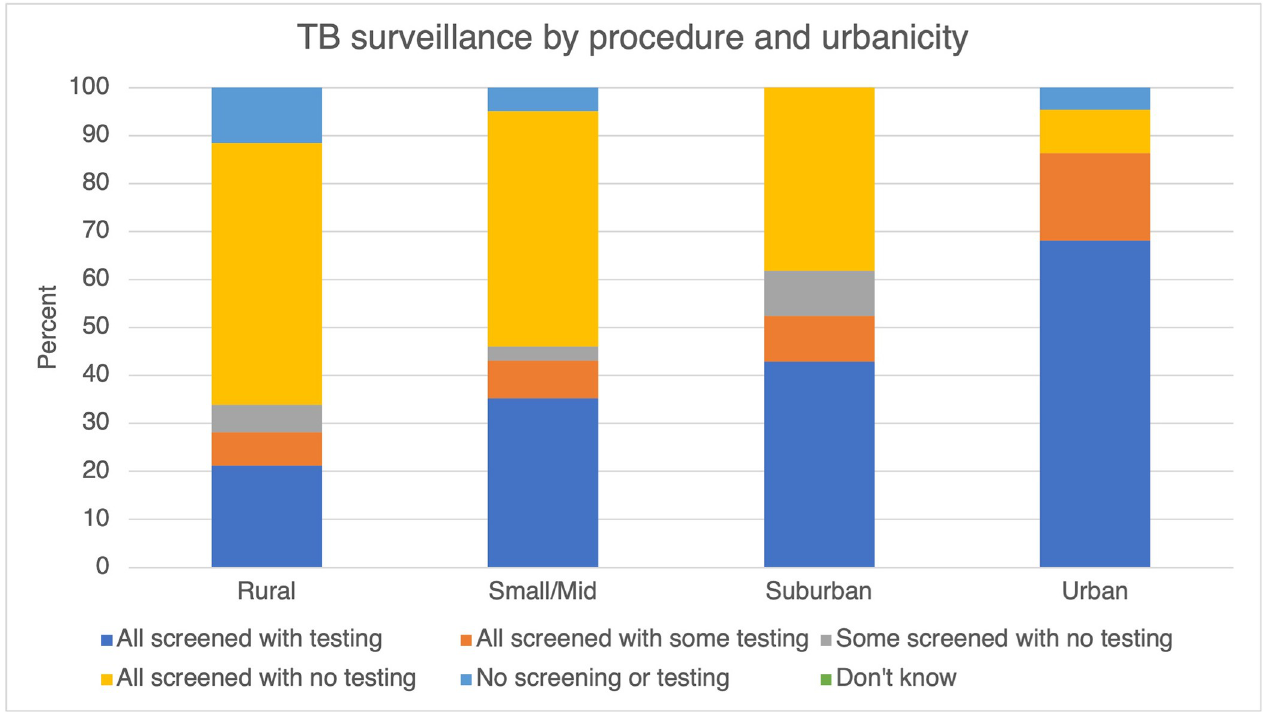
Fig 3. TB surveillance by procedure and urbanicity.